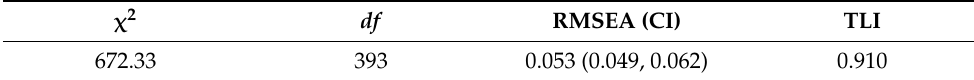
Table 13. Factor Structure Model Fit.